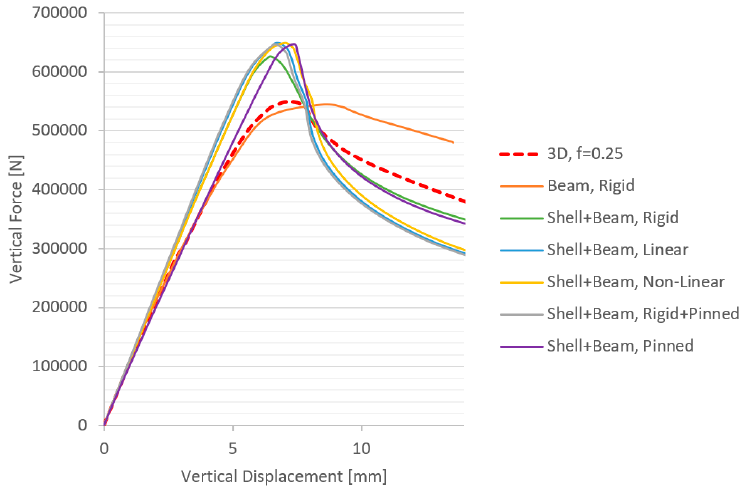
Table 5. Load capacity of the planar subassembly models compared.